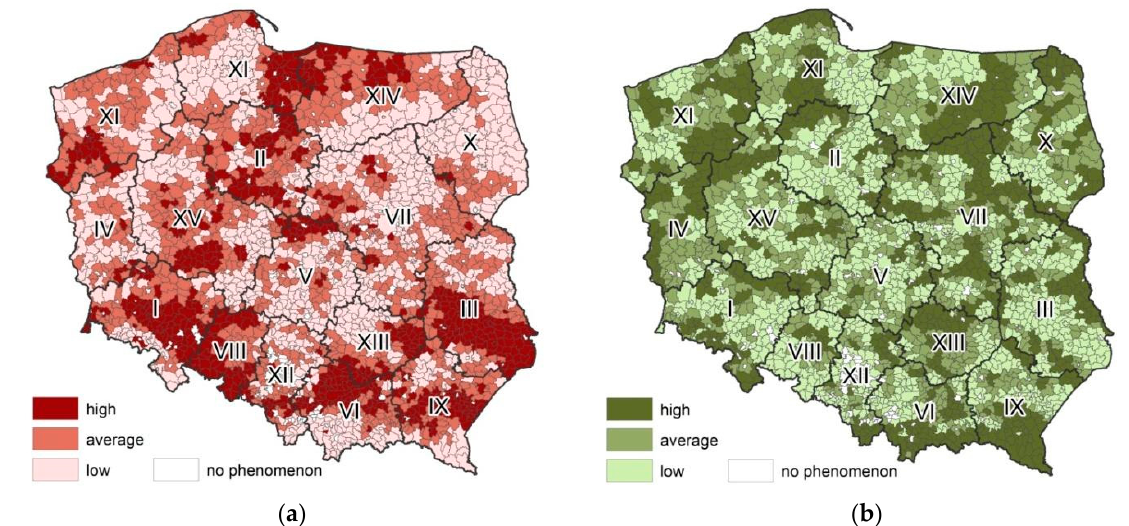
Figure 4. The quality of agricultural production space (( a ); APS) and the natural and ecological quality of areas (( b ); NEA). Source: own elaboration on [66–68,72,73].